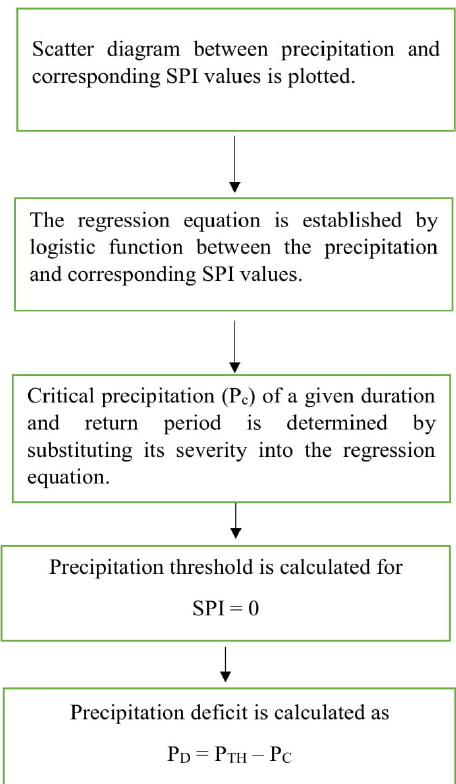
Figure 7. Step-by-step calculation of the precipitation deficit.